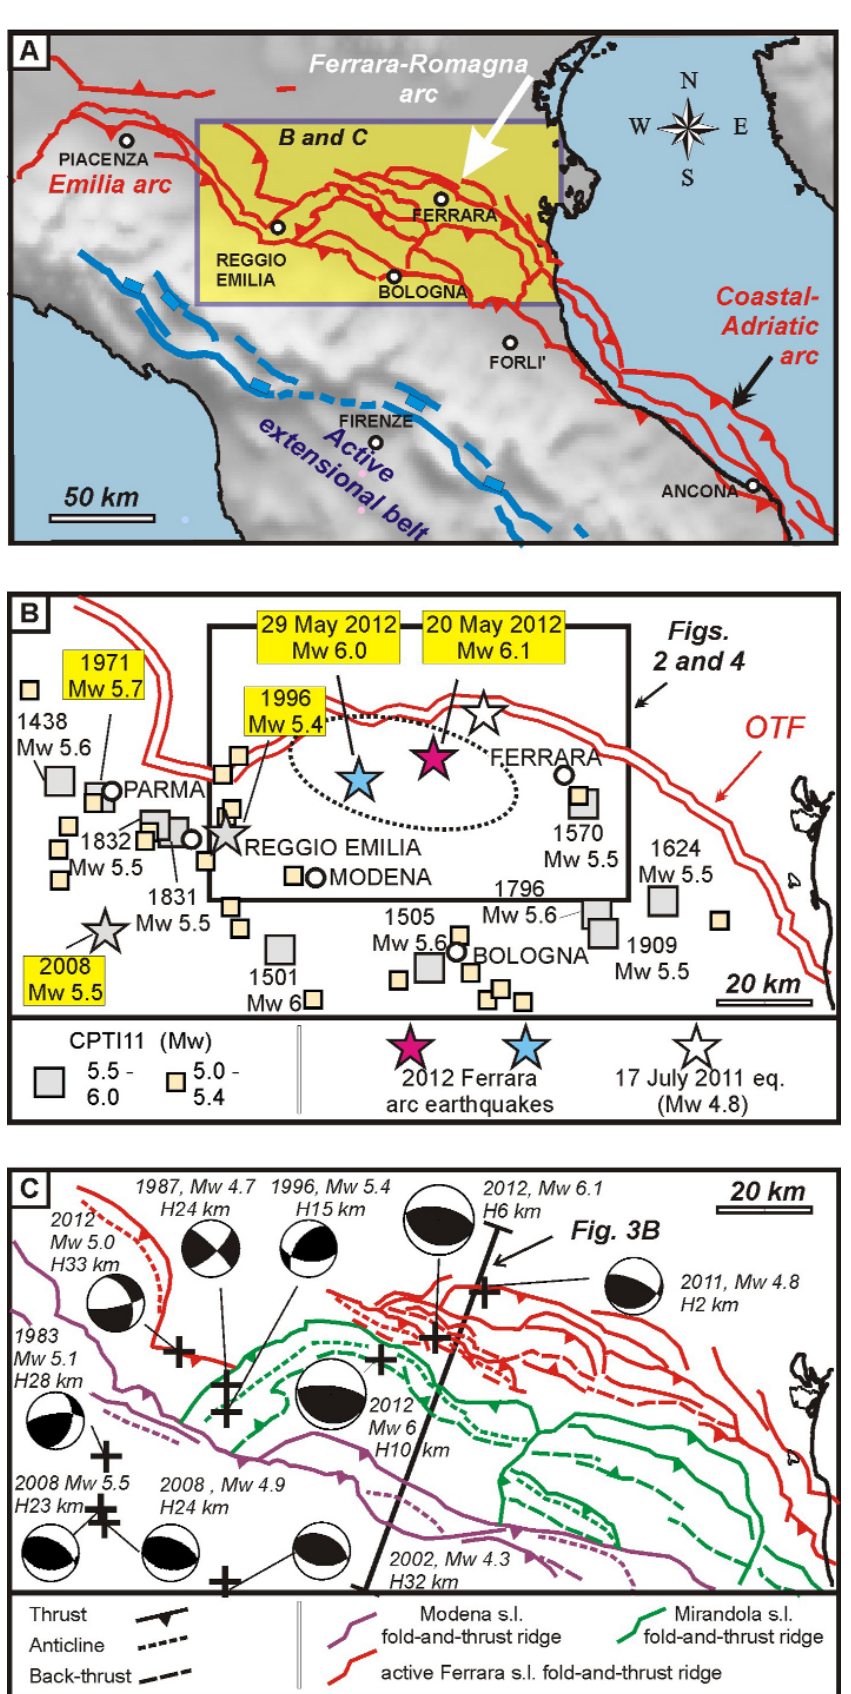
Figure 1. Seismotectonic framework of the Ferrara Arc 2012 earthquakes. (A) Schematic map of the Padan-Adriatic thrust belt of northern Italy, with the boundary of the study area (yellow rectangle). (B) Outer Thrust Front (OTF) of the Ferrara Arc, with historical and instrumental seismicity from the CPTI11 catalog and the ISIDe database. The dotted line is the areal extent of the distribution of the aftershocks for the May 19 to June 19, 2012, period. (C) Focal mechanisms of the major events, from the RCMT catalog, available at http://autorcmt.bo.